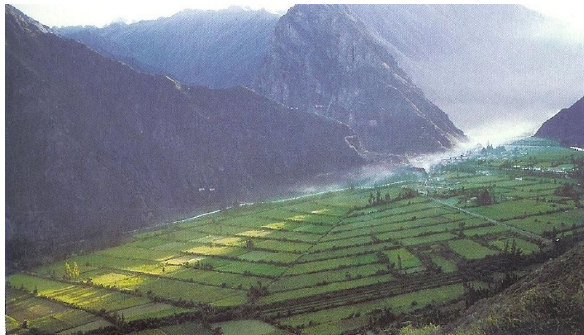
Figure 10: View on pyramid during the sunrise at summer solstice. © Salazar and Salazar 2005